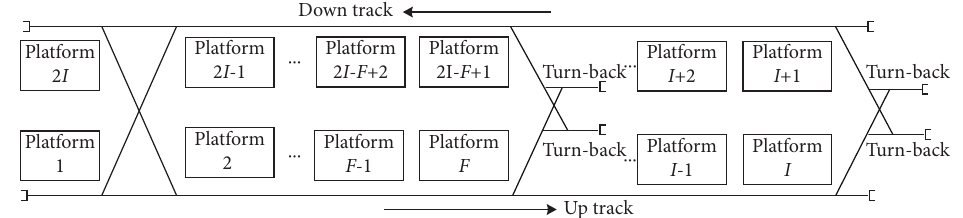
Figure 1: Schematic of the track layout of a URT line.